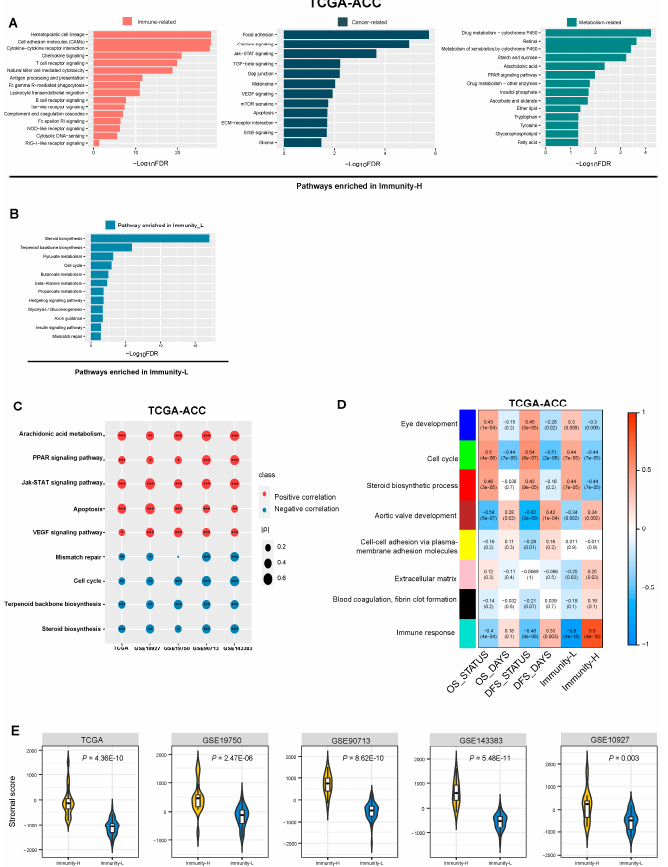
Figure 6. Pathways and gene ontology (GO) enriched in the immune subtypes of ACC. The KEGG pathways highly enriched in Immunity-H and Immunity-L in TCGA-ACC ( A , B ). ( C ) Spearman cor- relations between the enrichment scores of pathways upregulated in Immunity-H, Immunity-L, and immune scores in ACC. The correlation coefficients ( ρ ) and p -values are shown. * p < 0.5, ** p < 0.01, *** p < 0.001. ( D ) Eight gene modules that significantly differentiated ACC by subtype, survival time, or survival status identified by WGCNA. ( E ) Comparisons of stromal scores evaluated by ESTIMATE [7] between the immune subtypes of ACC (one-tailed Mann–Whitney U test, p <